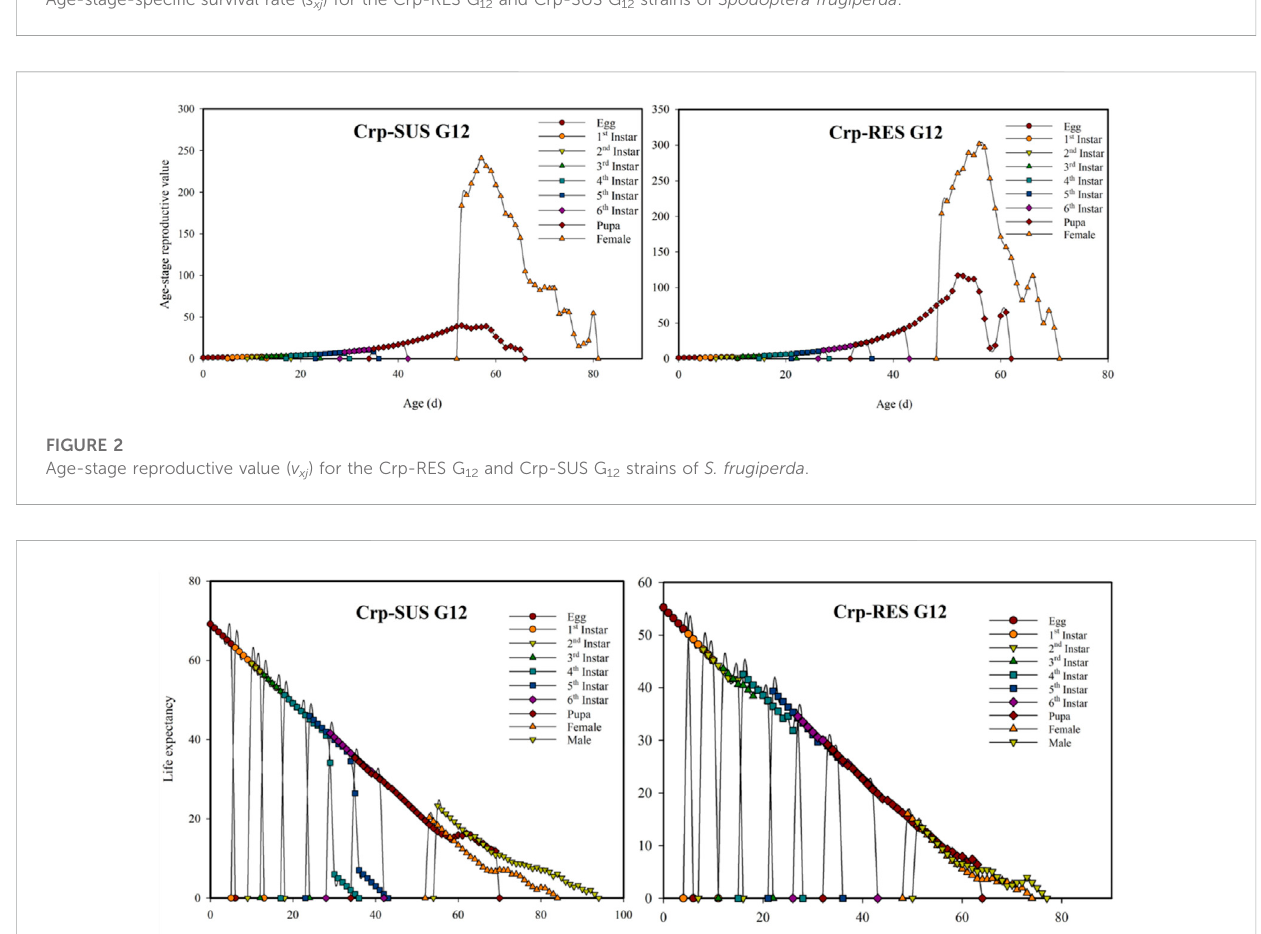
(Figure 3). The age-speci fi c survival rates ( l x ) for these strains indicated that the l x value decreased more quickly for the Crp- RES G 12 strain at 15 d than the Crp-SUS G 12 strain. In addition, the highest mean fecundity ( m x ) for Crp-RES G 12 was 140.85 eggs compared to the Crp-SUS G 12 that showed a mean fecundity of 85 eggs (Figure 4).